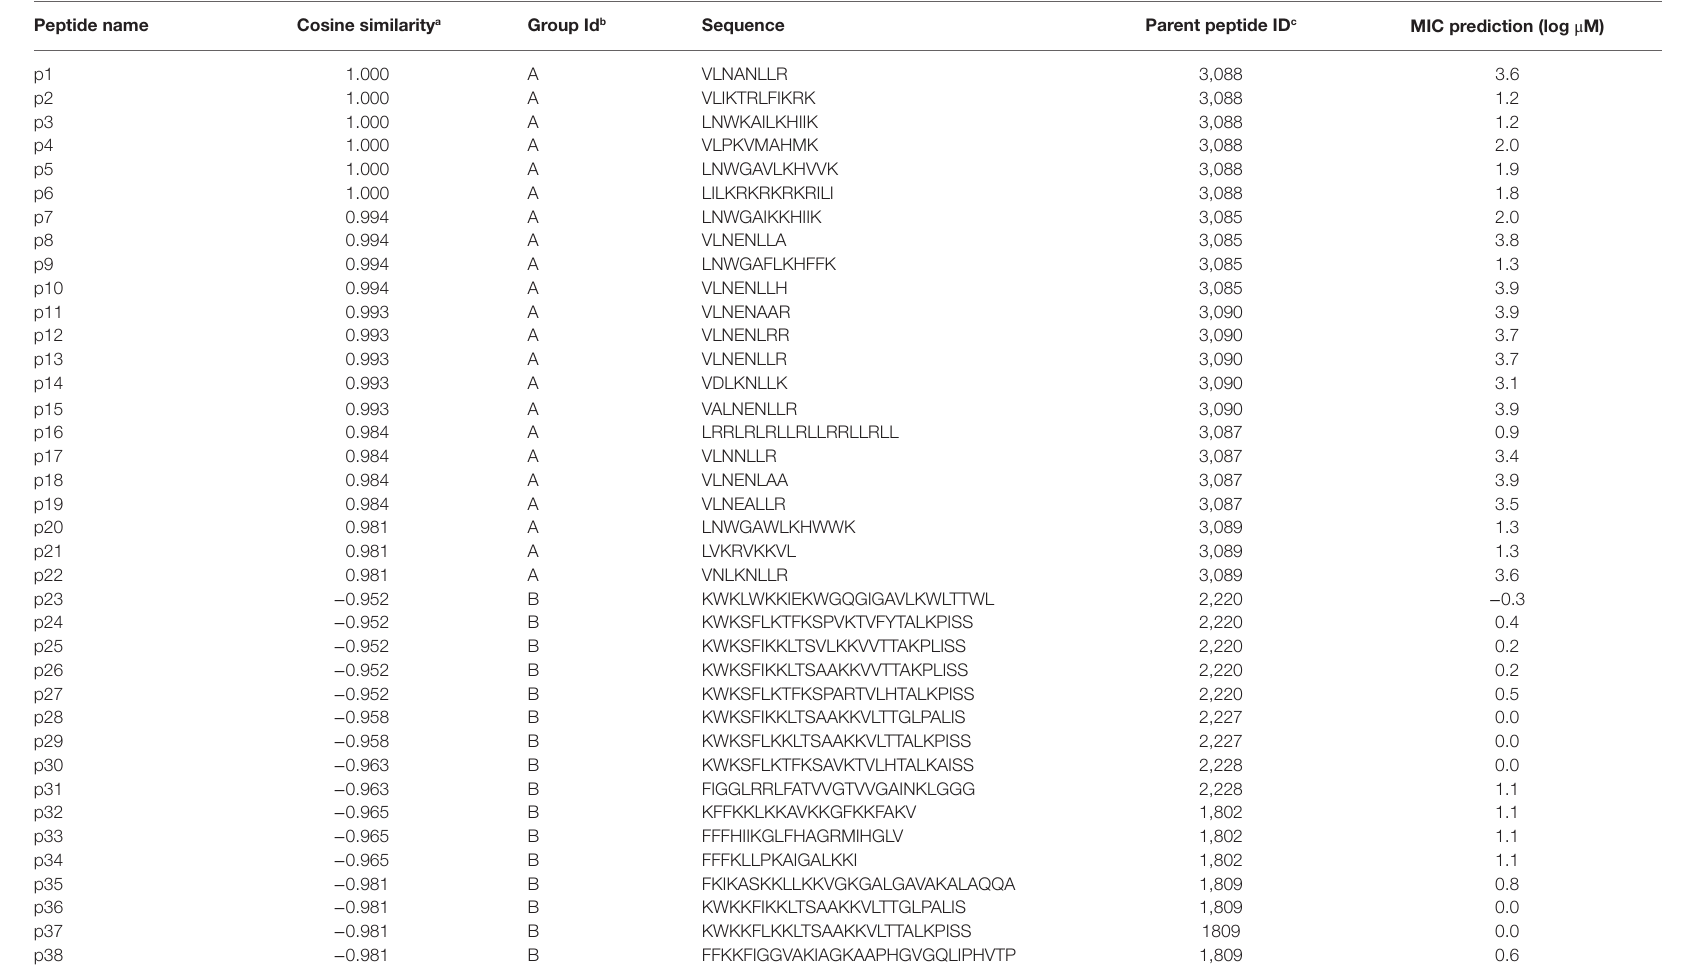
TABLE 1 | PepVAE-generated